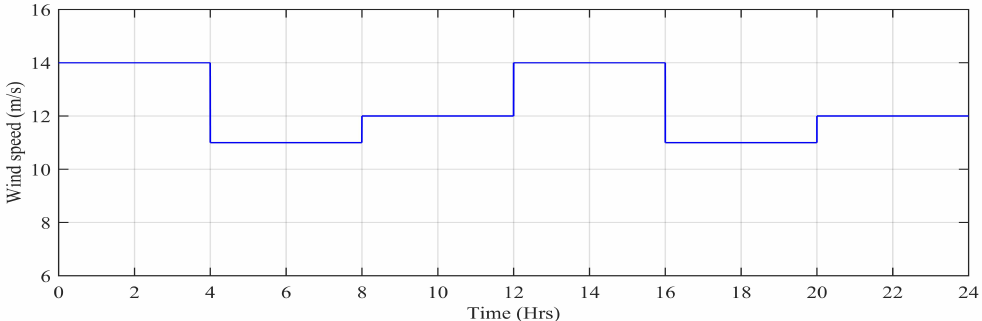
Figure 11. Wind speed